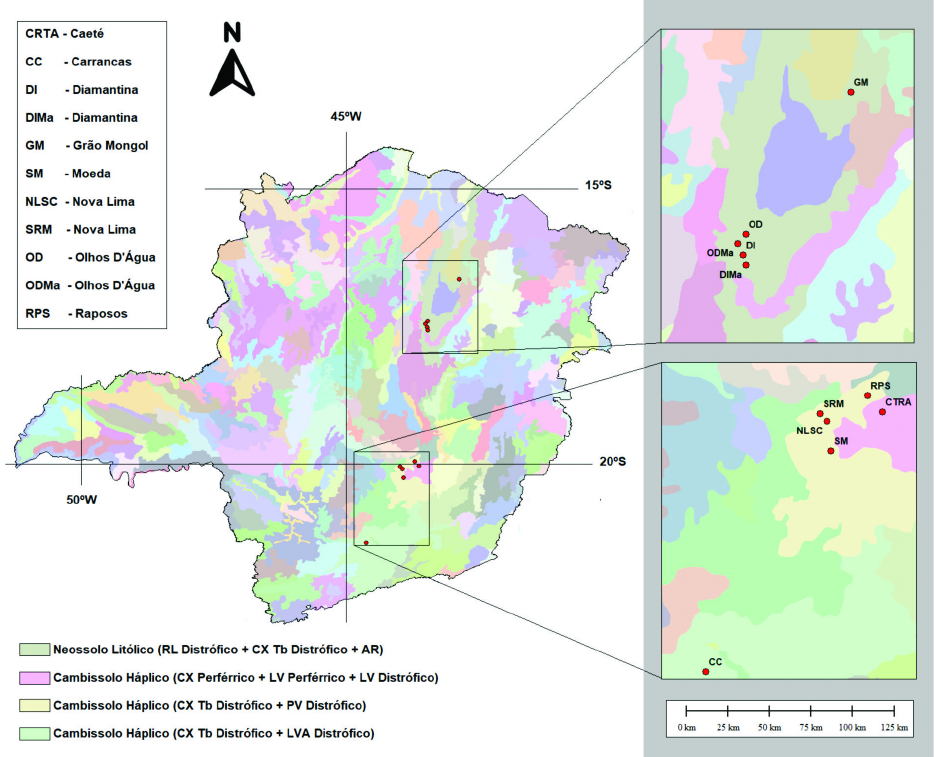
Figure 2. Classification map of soils in the regions of occurrence of natural populations of L. pinaster in the State of Minas Gerais,